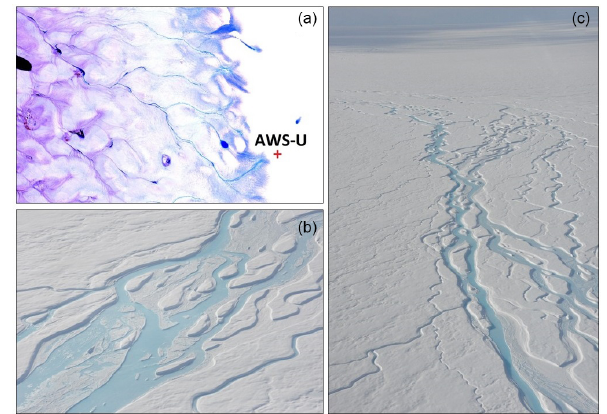
Figure 6. Panel (a) is a zoomed-in Landsat 7 image from 16 July 2012 showing free surface water in the area around AWS_U. The extent is marked on Fig. 1. The scan line correction failure was interpolated using the ENVI “replace bad data” routine based on Band 8 and visible surface water was enhanced using a modified normalized difference water index (Fitzpatrick et al., 2014). (b, c) Oblique aerial photographs of the active supraglacial channel net- work emerging from AWS_U well within the accumulation zone at 1840ma.s.l. and 140km from the ice-sheet margin on 13 August 2012. Image courtesy of Paul